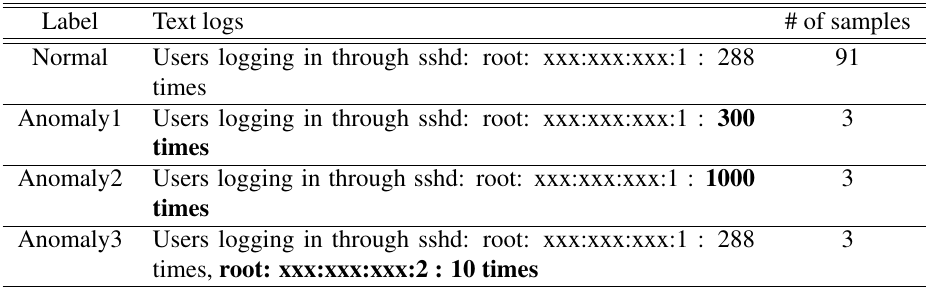
Table 2: Dummy sshd logs to test the ML algorithms.